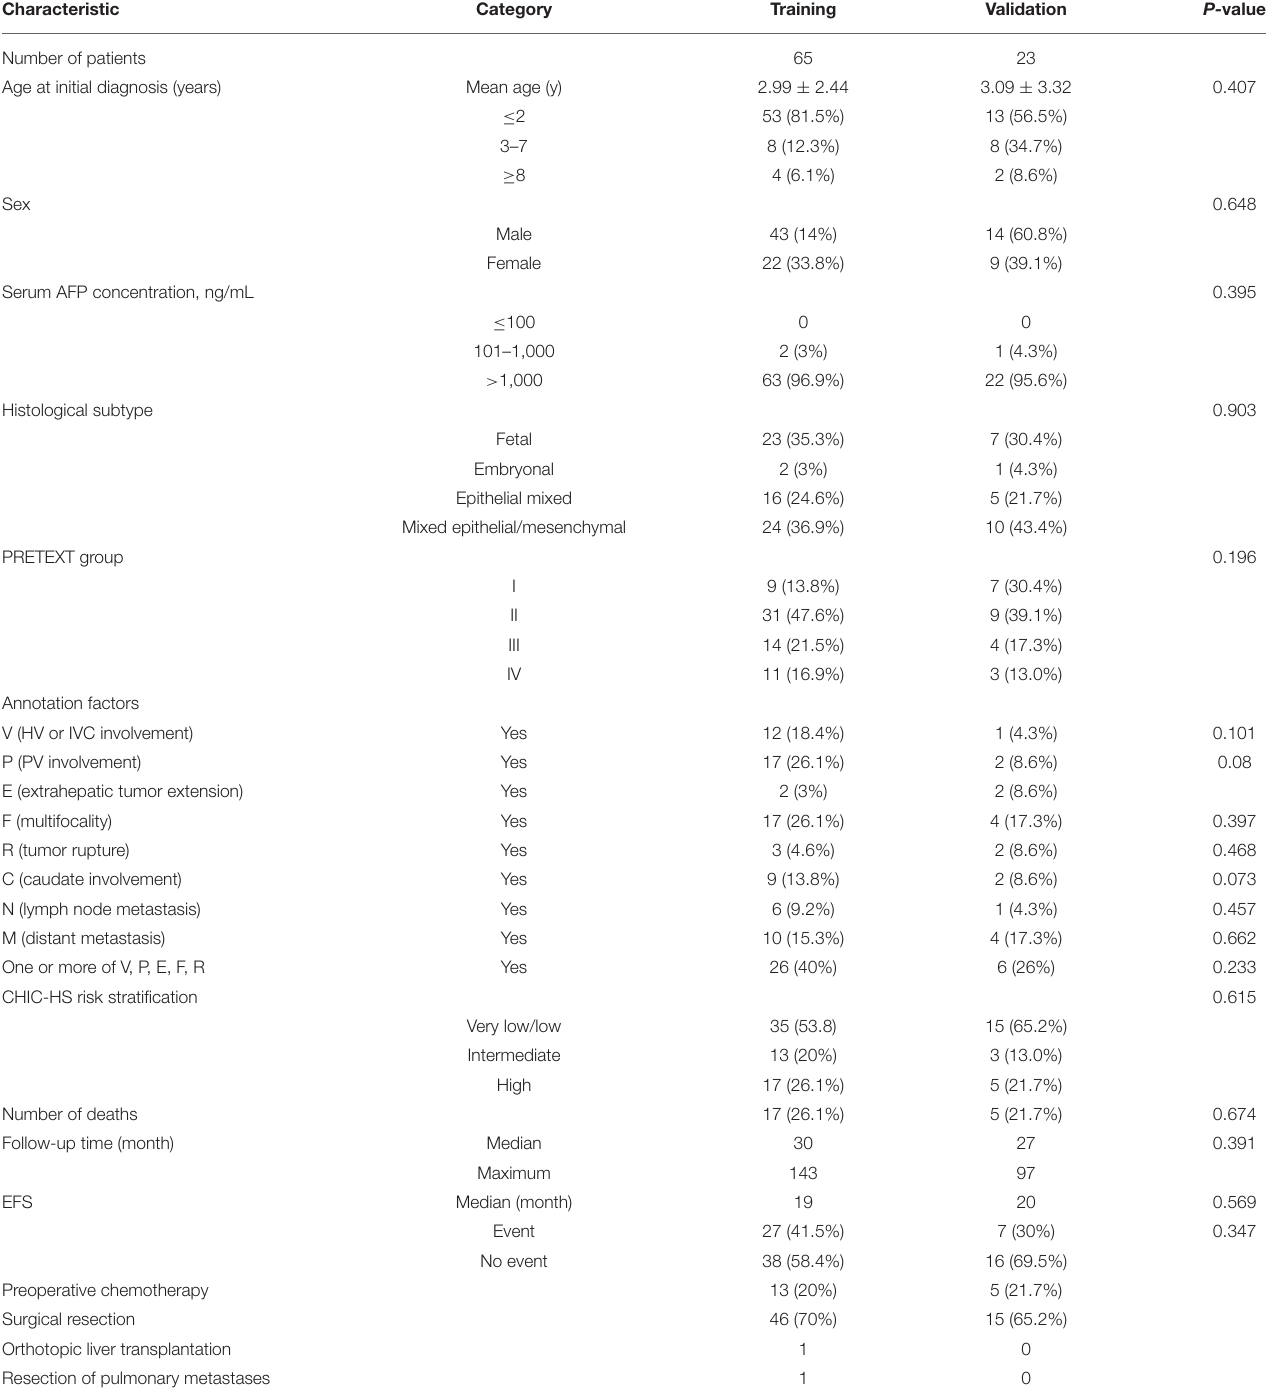
TABLE 1 | Baseline patient and tumor characteristics according to the radiomics score in the training and validation cohorts.